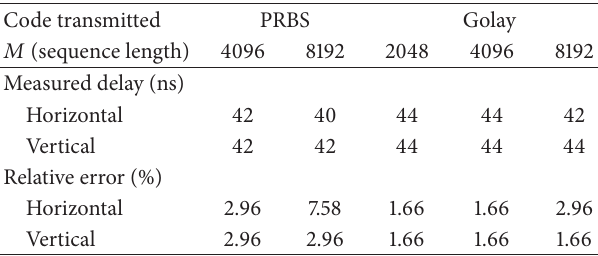
Table 6: Range estimation results—double target